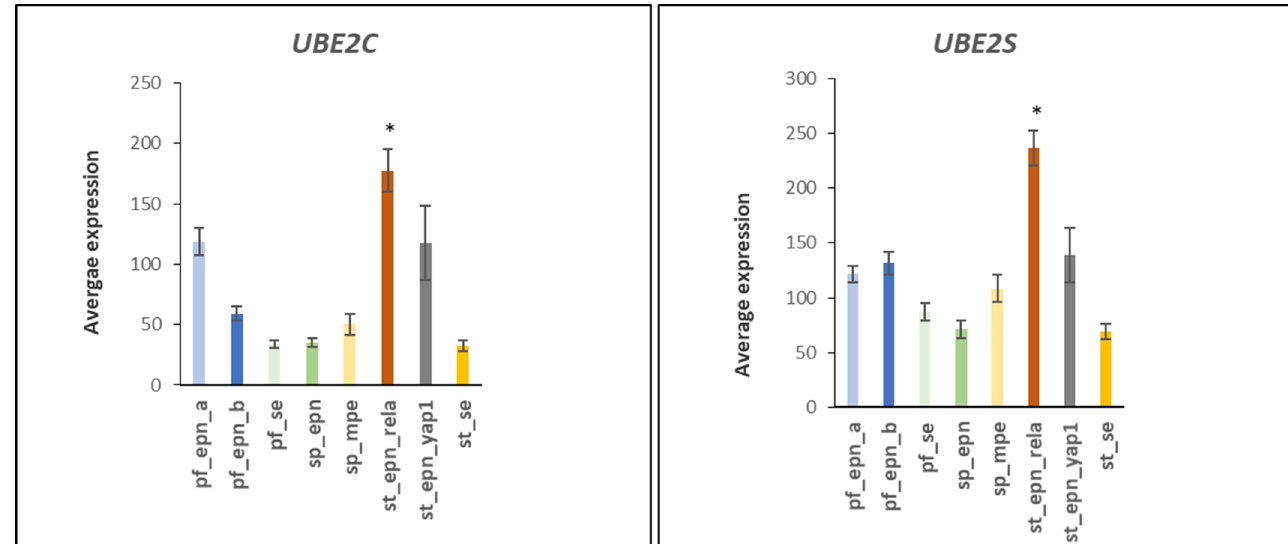
Figure 3. Expression of UBE2C and UBE2S is significantly increased in the ST_EPN_RELA subtype (F = 9.92, p = 1.28 × 10 − 10 ; F = 16.00, p = 1.19 × 10 − 16 ). * UBE2C -all significantly higher compared to other groups by t -test except ST - EPN_YAP1 group * UBE2S -all significantly higher compared to each of the other groups by t -test . Dataset GSE64415.